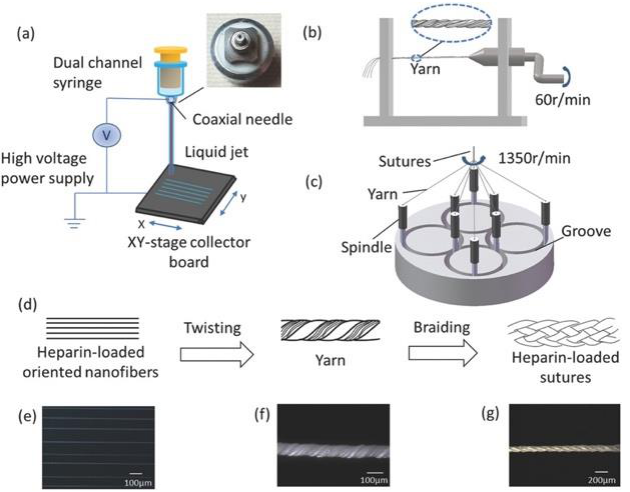
Figure 4. Sketch of suture fabrication. ( a ) Schematic of coaxial NFES; ( b ) schematic of twisting device (ten nanofibers twisted into yarn); ( c ) schematic of knitting machine; and ( d ) sutures: from fibers to suture. Optical microscopy images of ( e ) core–shell fibers ( × 70), ( f ) yarn ( × 210), and ( g ) suture ( × 70). Reproduced with permission from Ye et al., Macromol. Biosci; published by Wiley-VCH GmbH, Weinheim, 2018.